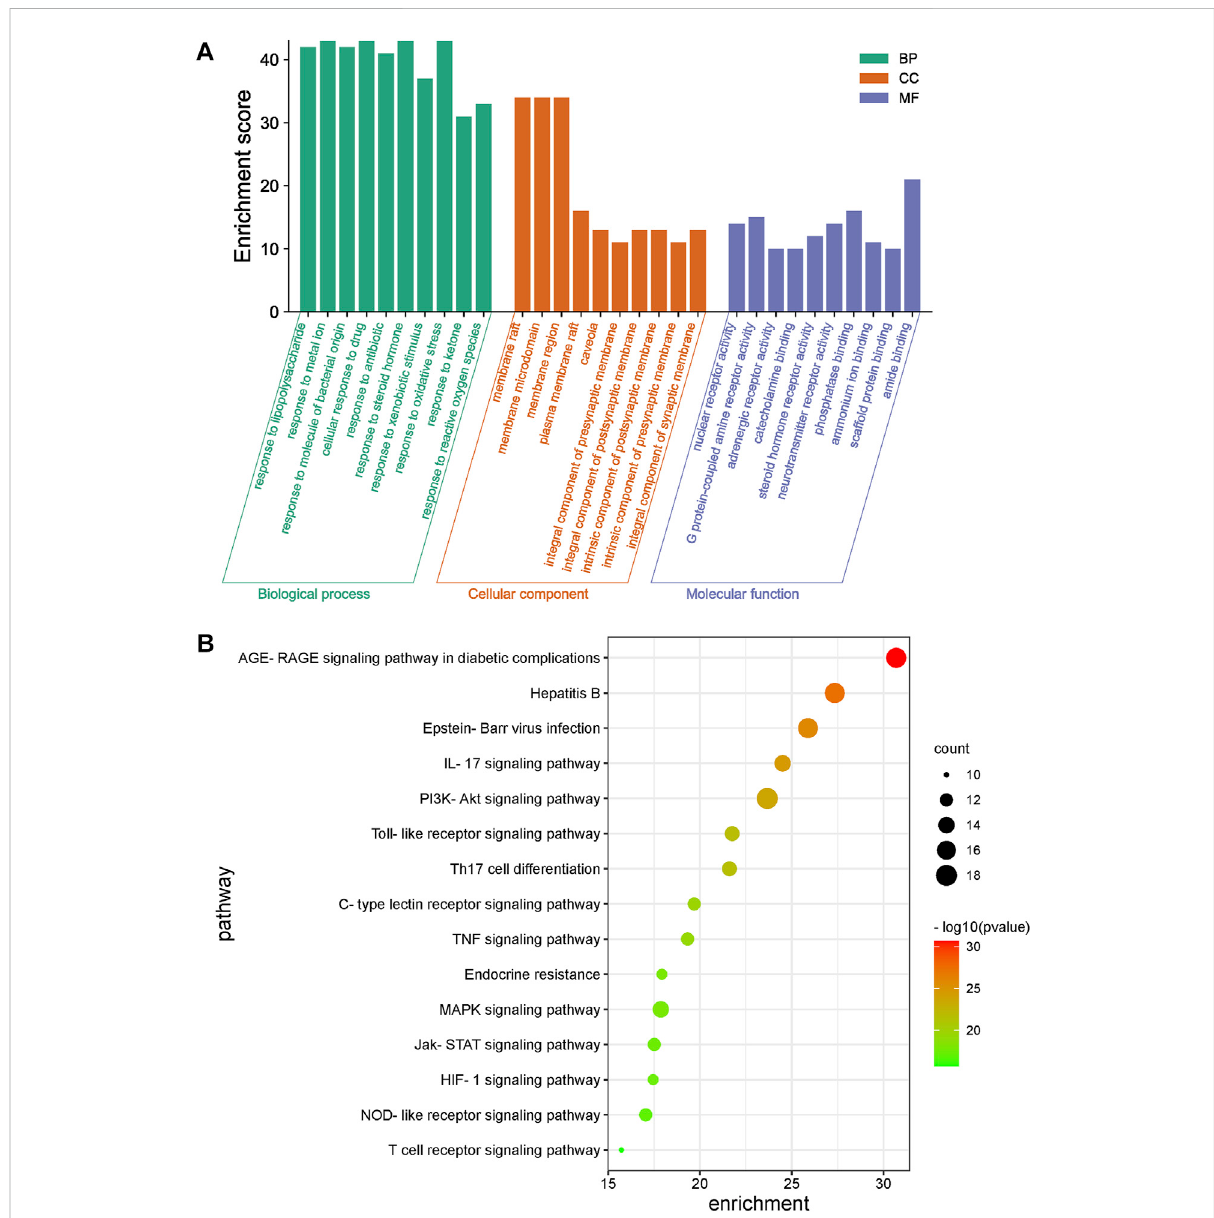
FIGURE 3 GeneOntology(GO)andKEGGenrichmentanalysisofcommongenesofLHQWandQFPDtargetedduringthetreatmentofmild-to-moderate COVID-19. (A) GO analysis was performed for the top 10 GO terms identi fi ed; X -axis represents GO term categories, while the y -axis represents the enrichmentscore. (B) A KEGGanalysisofthegenes wasperformed, andthetop 15 pathways are shown. The colorofthedot represents the p -value. The dot size represents the number of target genes enriched in the